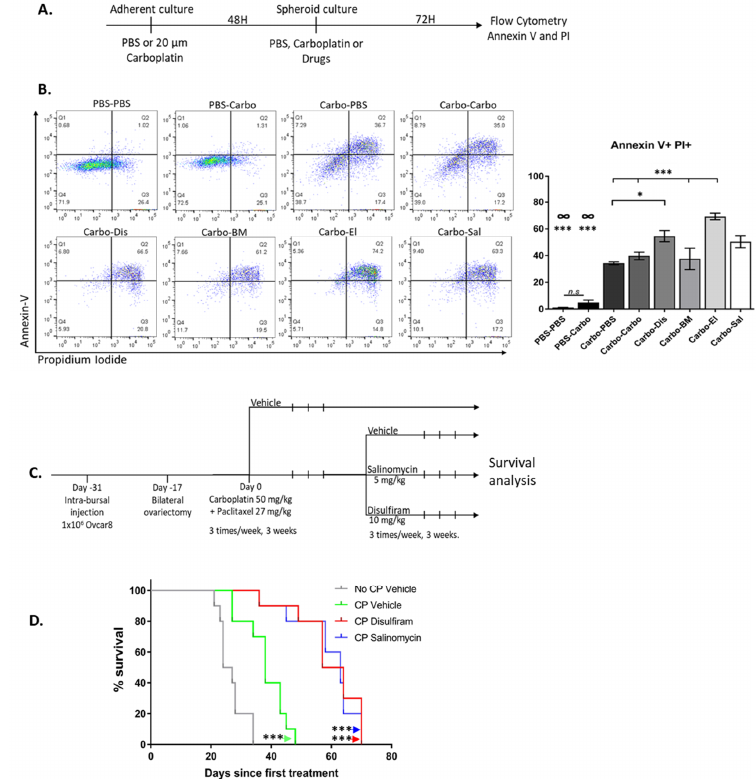
Figure 7. Drugs e ff ect on models of relapse in vitro and in vivo. ( A ) Schematic of the in vitro relapse model of OVCAR8 cells treated with PBS or 20 µ M carboplatin under adherent conditions for 48 h, and then switched to TIC-enriching spheroid growth conditions and treated with the candidate drugs at LD50concentrations, carboplatinat20 µ MorPBSforafurther72h. ( B )Representativeimages(leftpanel) of Annexin V and PI staining that was used to quantify cell death (right panel) Carbo = Carboplatin, Dis = Disulfiram, BM = Bardoxolone Methyl, El = Elesclomol, Sal = Salinomycin. Graphs represent mean and SEM Graphs represent mean and SEM of each treatment, distinguished by di ff erent degrees of grayscale shading, n.s = not significant, ∞ = compared to all groups, * p < 0.05, *** p < 0.001. ( C ) Schematic of the in vivo relapse model. ( D ) Kaplan-Meier survival analysis of mice treated with vehicle only (grey, “No CP Vehicle”), Carboplatin and Paclitaxel (green, “CP Vehicle”), Carboplatin and Paclitaxel followed by Disulfiram (red, “CP Disulfiram”) and Carboplatin and Paclitaxel followed by Salinomycin (blue, “CP Salinomycin”). Survival was measured in days since the first treatment *** p < 0.001 compared to vehicle